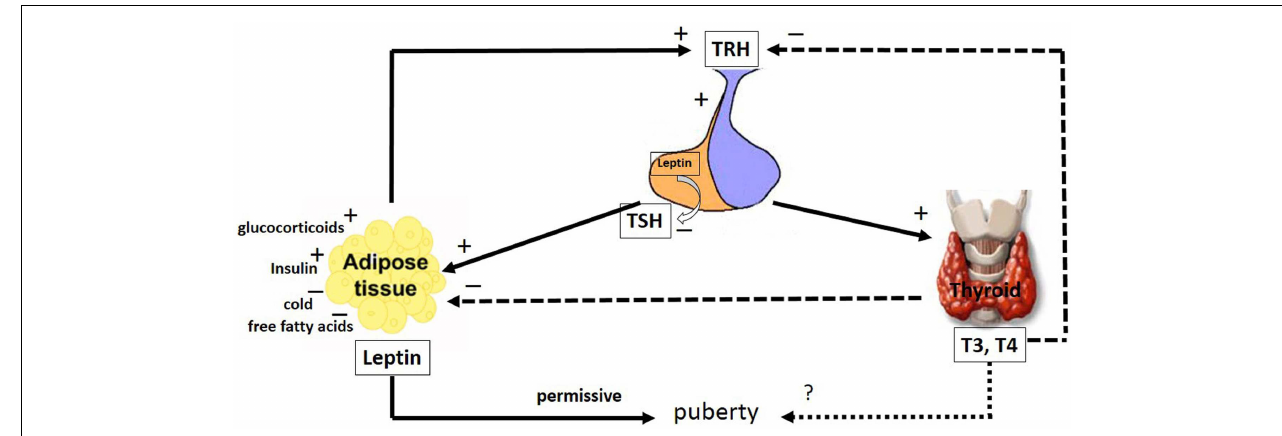
produced in the pituitary is capable of inhibitingTSH secretion. Leptin secretion from adipose tissues is regulated by stimulatory factors such as TSH, glucocorticoids,T 4 andT 3 and insulin as well as inhibitory factors such as, cold and free fatty acids. Leptin and the thyroid hormones,T 4 andT 3 , have a role in puberty; however, whereas the leptin role is permissive, the T 4 andT 3 role remains uncertain.The arrays indicate: solid (stimulatory), dashed (inhibitory), dotted (uncertain) signals.TRH, thyreotrophin release hormone;TSH, pituitary tireotropin;T 3 , 3,5,3 (cid:48) -triiodo- L -thyronine;T 4 , thyroxine. See text for